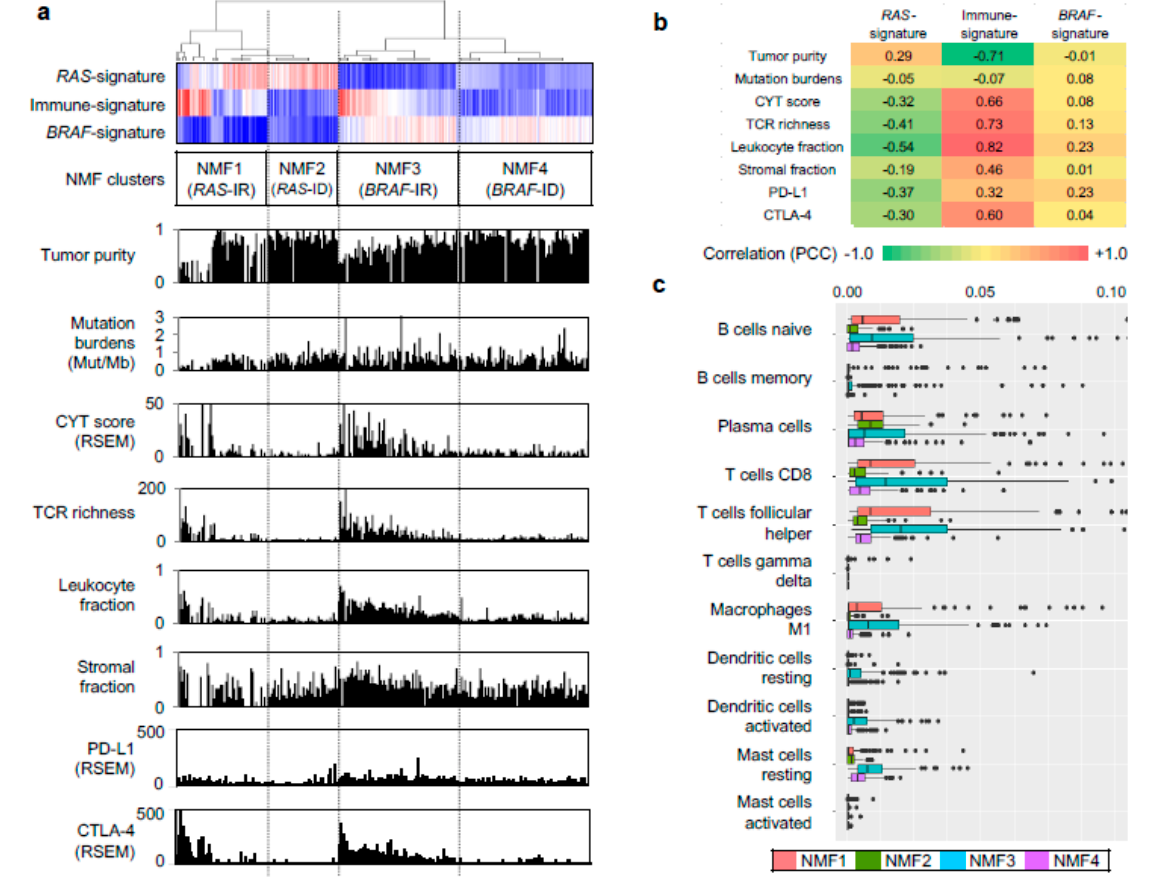
Figure 2. Characterization of immune signature. ( a ) Three metagene signatures and four NMF clusters are shown as Figure 1c. Eight immune-related genomic and pathologic features shown are tumor purity, mutation burden, CYT score, TCR richness, fraction of leukocytes and stromal cells, and expression level of PD-L1, CTLA-4 immune checkpoints; ( b ) Pearson correlation coefficients calculated for possible pairs of three metagene signature levels and eight immune-relate features across TCGA PTC expression profiles. A heatmap shows the level of correlation with a color legend; ( c ) Immune cell abundance ( x -axis) estimated by CIBERSORT algorithm for 11 immune cell subsets ( y -axis). Among 22 subsets of CIBERSORT output (LM22), those that are significant ( p < 0.05; ANOVA) against the four NMF clusters are